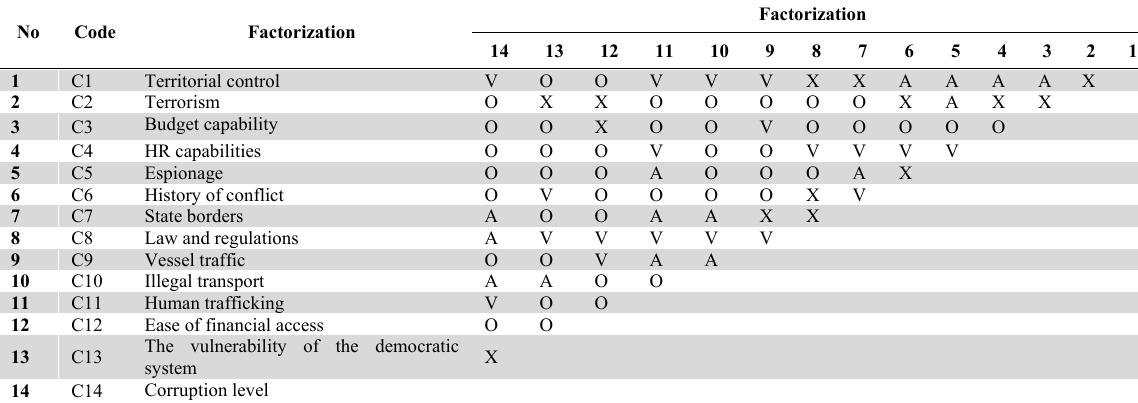
SSIM on the Social Vulnerability Analysis